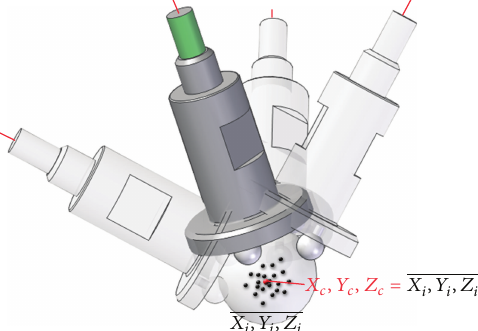
Figure 5: Retroreflector